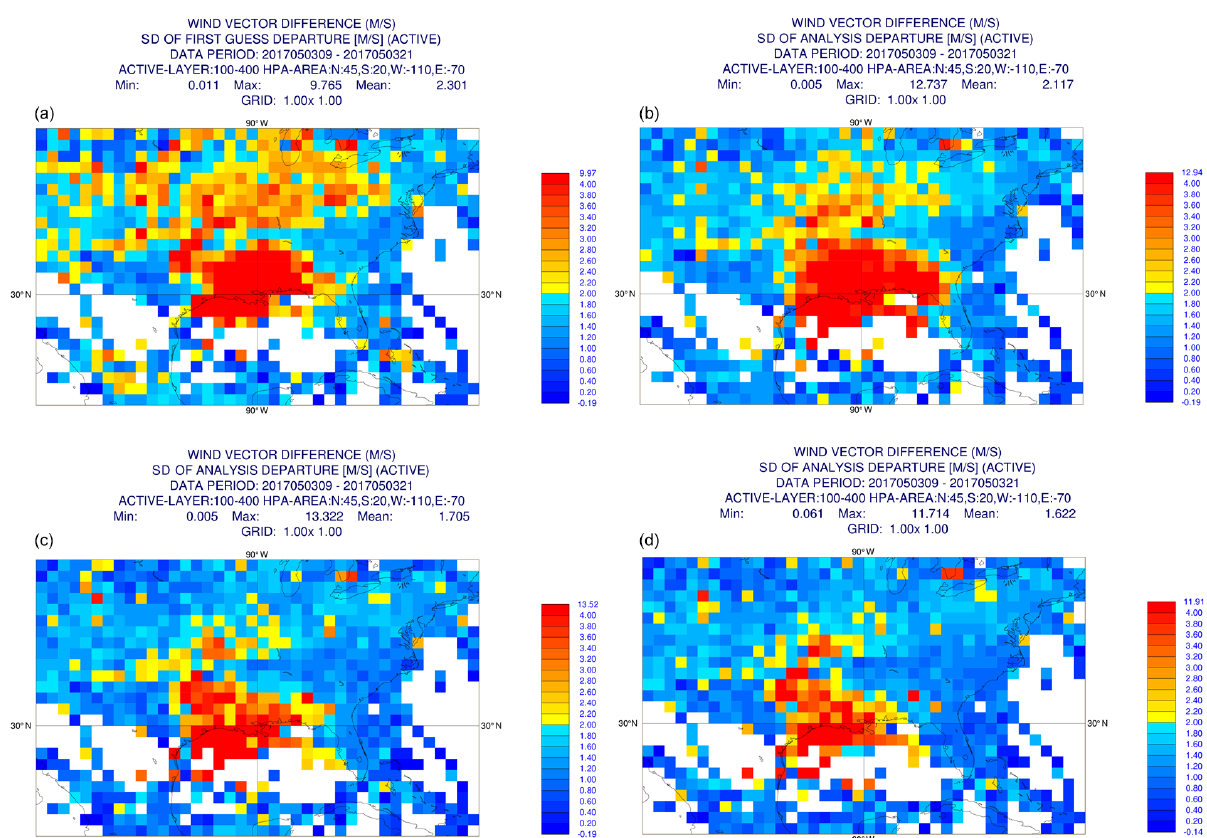
Figure 10. Standard deviation of wind vector observation minus model departures over the 09:00 to 21:00UTC assimilation window of 3 May 2017 in the 100–400hPa layer for a pre-operational version of the IFS 43R3 cycle: first guess departures (a) ; a one outer loop analysis departures (b) ; a three outer loop analysis departures (c) ; a five outer loop analysis departures (d)